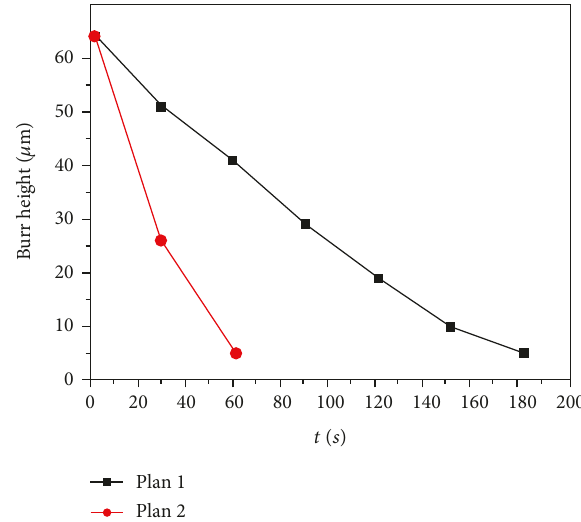
Figure 7: Comparison of burr height in each